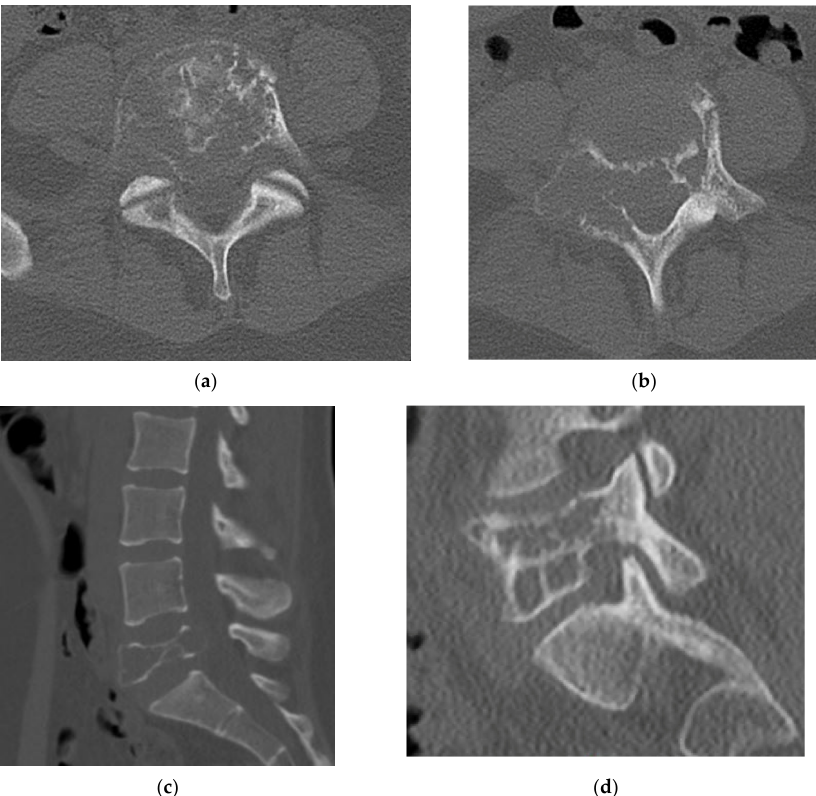
Figure 2. ( a ) Axial CT cuts of L5 vertebral body shows pseudotrabeculation of vertebral body with eccentric thinning of the right vertebral body cortex and formation of a contralateral sclerotic mar- gin. ( b ) Bilateral pedicle involvement with near complete destruction of right sided L5 pedicle. ( c ) Sagittal cuts of L5 vertebral body shows loss of vertebral height indicating compression fracture with no retropulsion of bony elements. The lesion is seen to by lytic with cortical erosion especially in the posterior vertebral body. ( d ) Sagittal cut of L5 vertebral body demonstrates classic “soap bub-